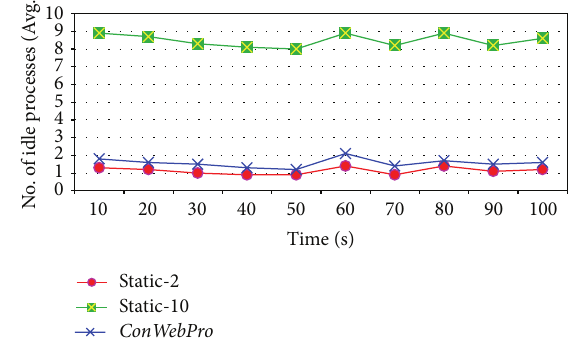
Figure 7: The average idle processes at Gangneung-Wonju National University web